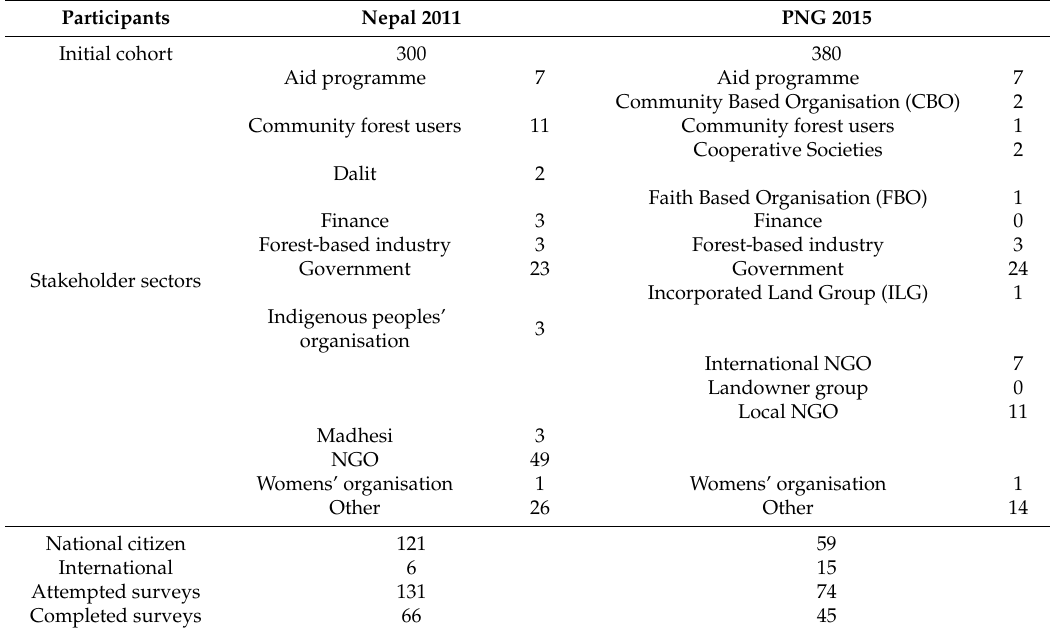
Table 2. Summary of REDD+ survey participants in Nepal and